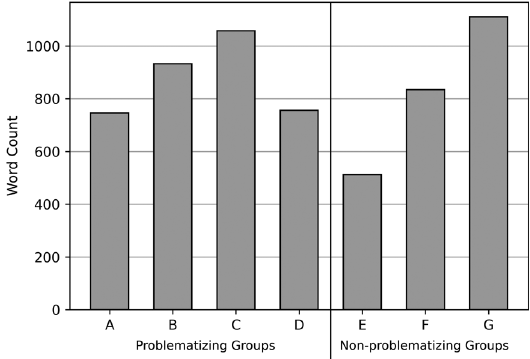
FIG. 5. Word count of text in lab notes for each group. Equations and data tables are excluded from the counts. Group